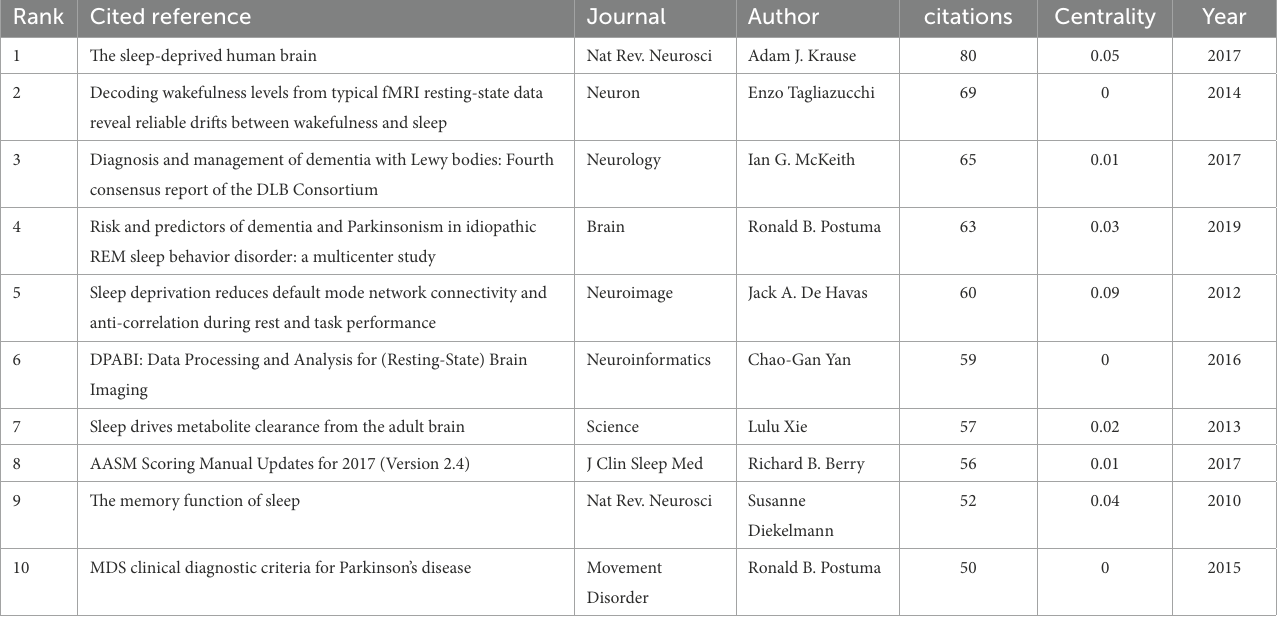
TABLE 5 Top 10 literature in terms of total citations.